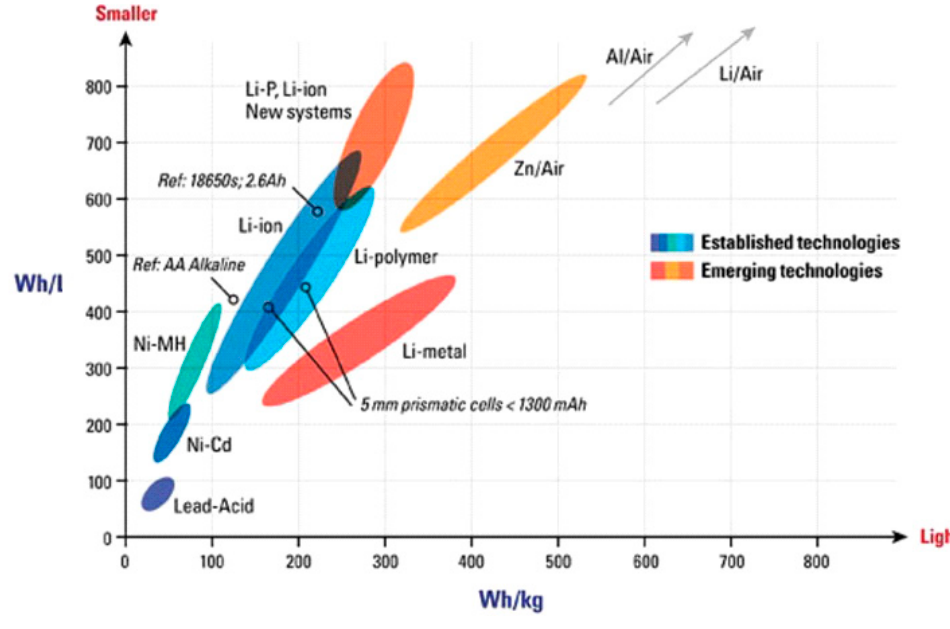
Figure 1. Battery technology comparison.